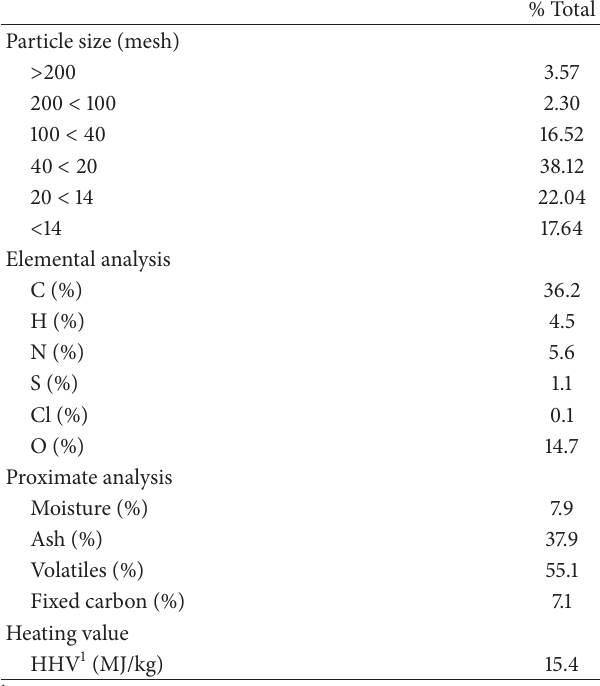
Table 1: Sieve distribution and properties of sewage